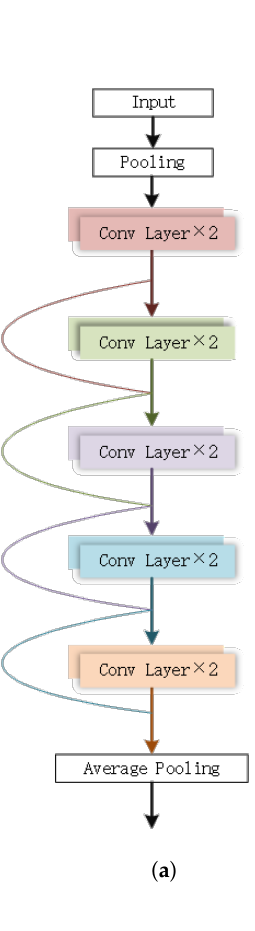
used in our work. As a method to fit a fonctionelle, DNN is also effective outside the field